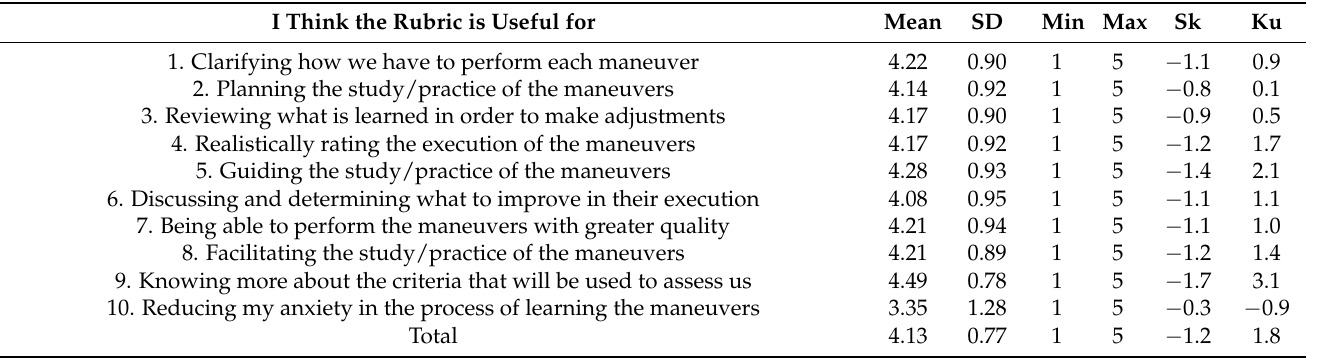
Table 2. Descriptive statistics for